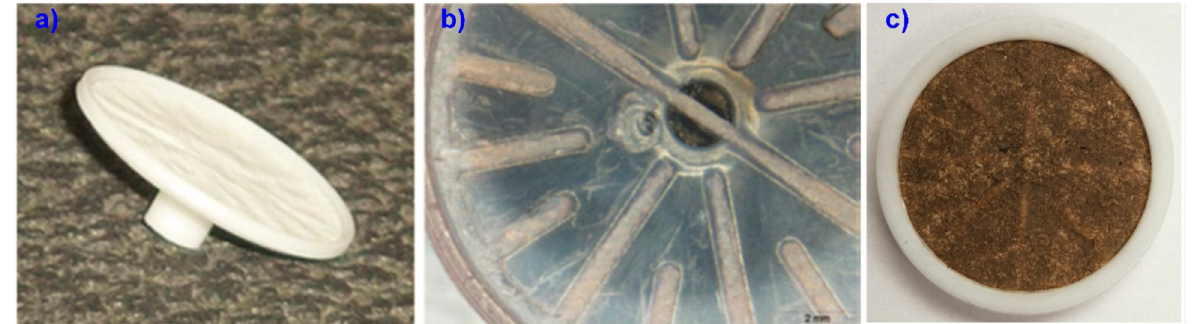
Figure 4. Examples of: ( a ) a clean PDM filter holder; ( b ) backside of a PDM filter holder showing structural bars; and ( c ) a PDM filter with a nonuniform particle deposit affected by the filter holder [64]. Reprinted by permission of Taylor & Francis Ltd.